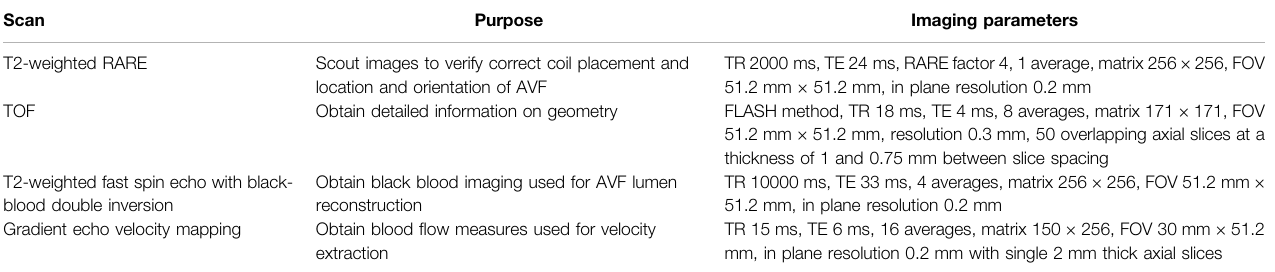
TABLE 1 | Contrast-free MRI acquisition protocol. Note: RARE (cid:2) Rapid Acquisition with Relaxation Enhancement, TR (cid:2) Repetition time, TE (cid:2) Echo Time, TOF (cid:2) Time of Flight. Scan Purpose Imaging parameters T2-weighted RARE Scout images to verify correct coil placement and location and orientation of AVF